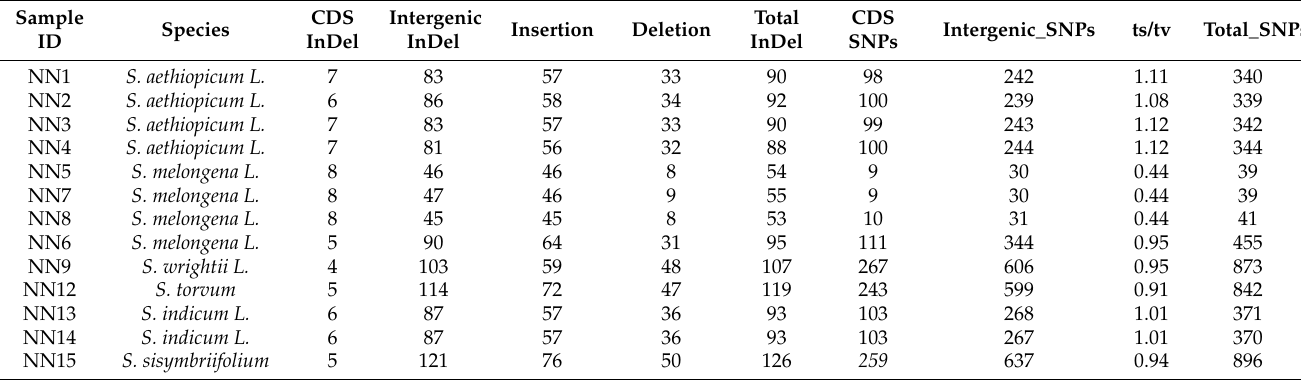
Table 5. InDel and SNP types of 13 cp